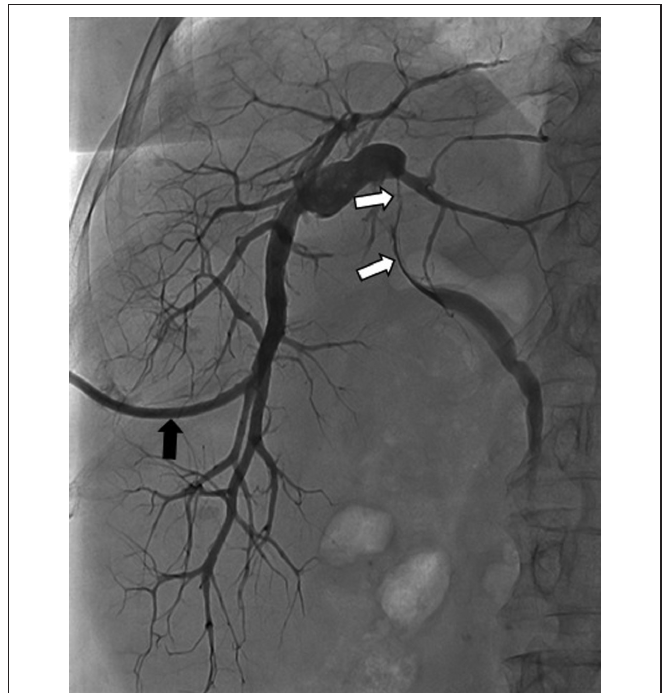
Figure 2. Percutaneous transhepatic cholangiography and biliary drainage. Cholangiography obtained via an 8-F external biliary drainage catheter (black arrow) shows strictures of the main hepatic duct (white arrows), with intrahepatic bile ducts dilatation.